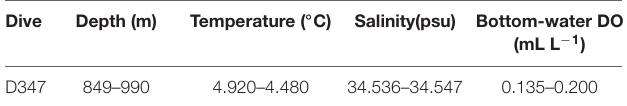
TABLE 3 | Environmental variables recorded near the seafloor during the ROV dive D347 in the NW limit of Guaymas Basin and the Sonoran Margin.